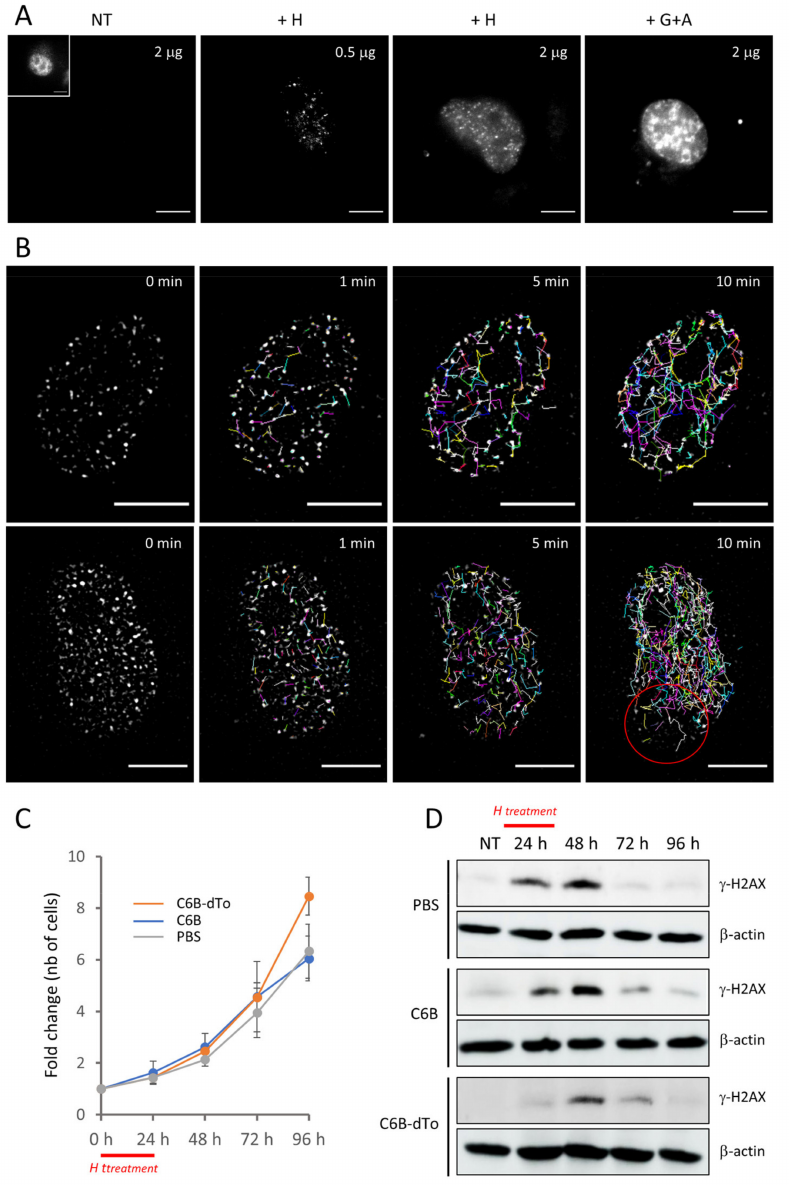
Figure 6. Visualization of the binding of the bivalent nanobody in live H1299 cells and analysis of its effect after pulse treatment with hydroxyurea. ( A ) Representative wide-field fluorescence